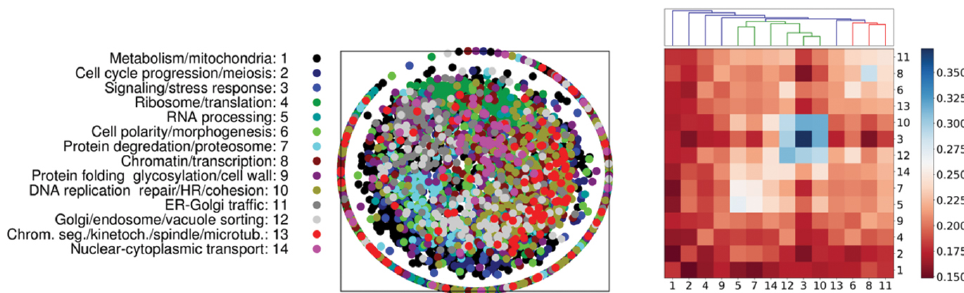
Figure 1: An illustration of our approach for constructing a functional organization map for COEX data. Left: the 14 color- coded functions that we use to group genes. Middle: a 2D embedding of the colour-coded genes (according to their func- tion) based on COEX dataset (the larger is the absolute value of their co-expression, the closer are two genes in 2D space). While the plot shows some functionally coherent regions, functions are heavily interlaced. Right: the functional organiza- tion map (heat map) with hierarchically clustered functions. Blue means high omics functional similarity, i.e. low distance between functions. Due to heavy interlacing of biological functions illustrated in the middle panel, the average functional similarity of genes in one functional groups (measured as described in Section 2.1 for each of the omics data set) are not high, hence we do not have a blue diagonal. Also, note that if the diagonal was blue, that would mean that the biological functions are completely separated from each others, which is not the case in